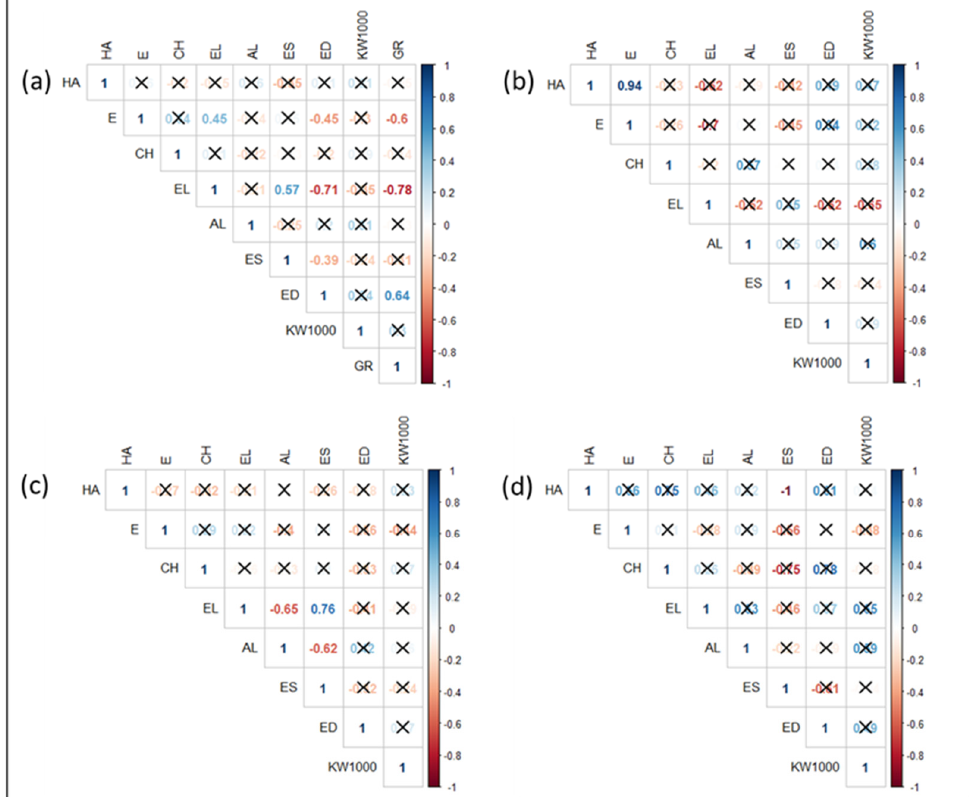
Figure 6. Pearson correlation matrix of 8 morpho-agronomic traits of tetraploid wheats. Numbers indicate the correlation coefficient: positive correlations are displayed in blue and negative correlations in red. Non-significant correlations ( p > 0.05) are marked by a black cross. ( a ) Trait correlation among all the genotypes (the membership group identified in Figure 4 is included in the analysis as the “Group” variable); ( b ) trait correlation among the genotypes of “Group I”; ( c ) trait correlation among the genotypes of “Group II”; ( d ) trait correlation among the genotypes of “Group III”. Habitus (HA), time of earing (E), culm height (CH), ear length (EL), awns length (AL), ear shape (ES), ear density (ED), 1000-kernel weight (KW1000).